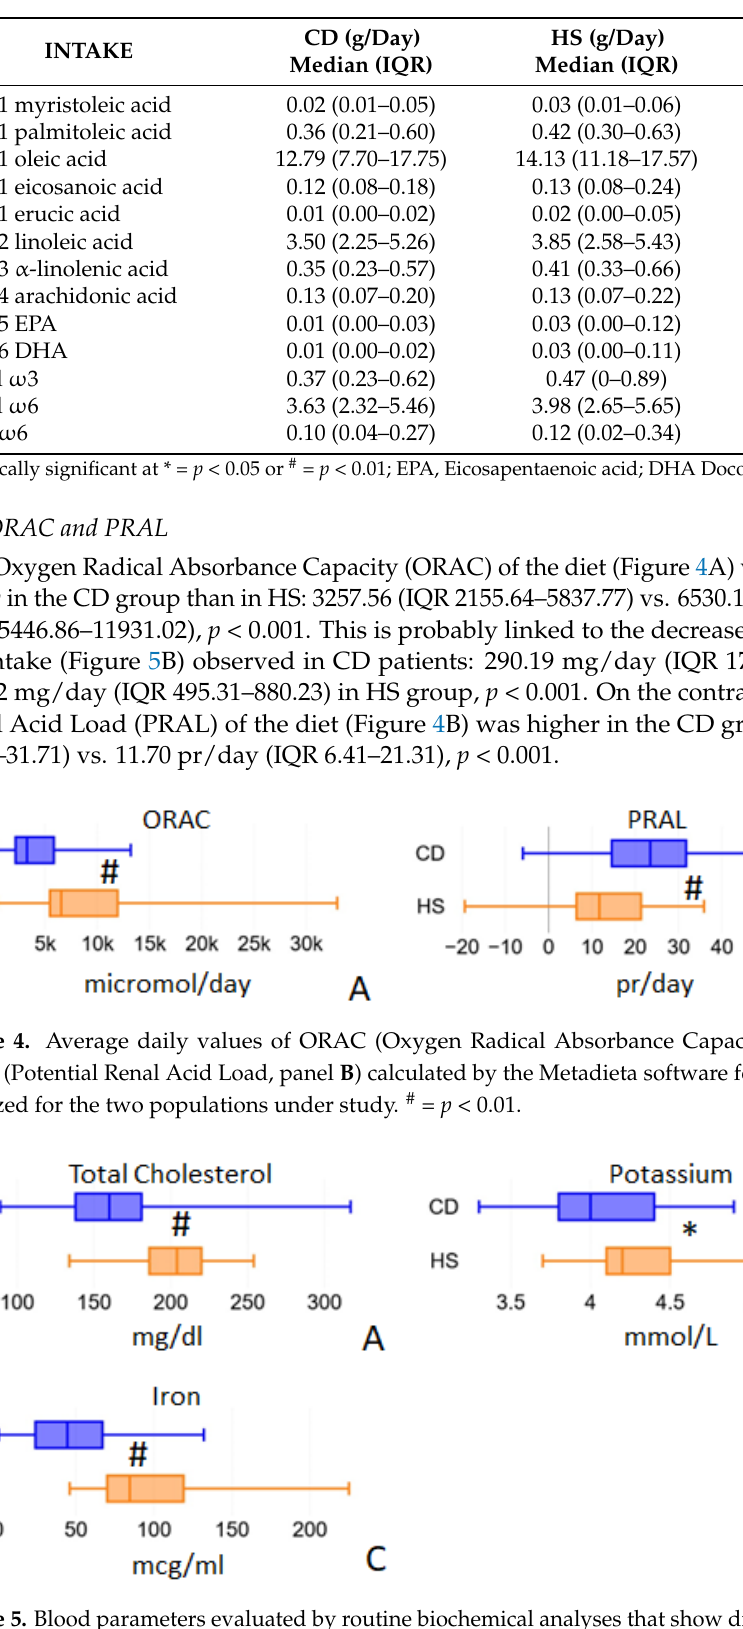
Figure 5. Blood parameters evaluated by routine biochemical analyses that show differences between the two study cohorts: total cholesterol (panel A ), potassium (panel B ) and iron (panel C ). * = p < 0.05; # = p < 0.01.